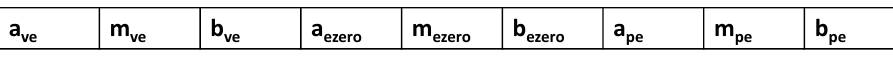
Figure 6. Representation of an individual for genetic